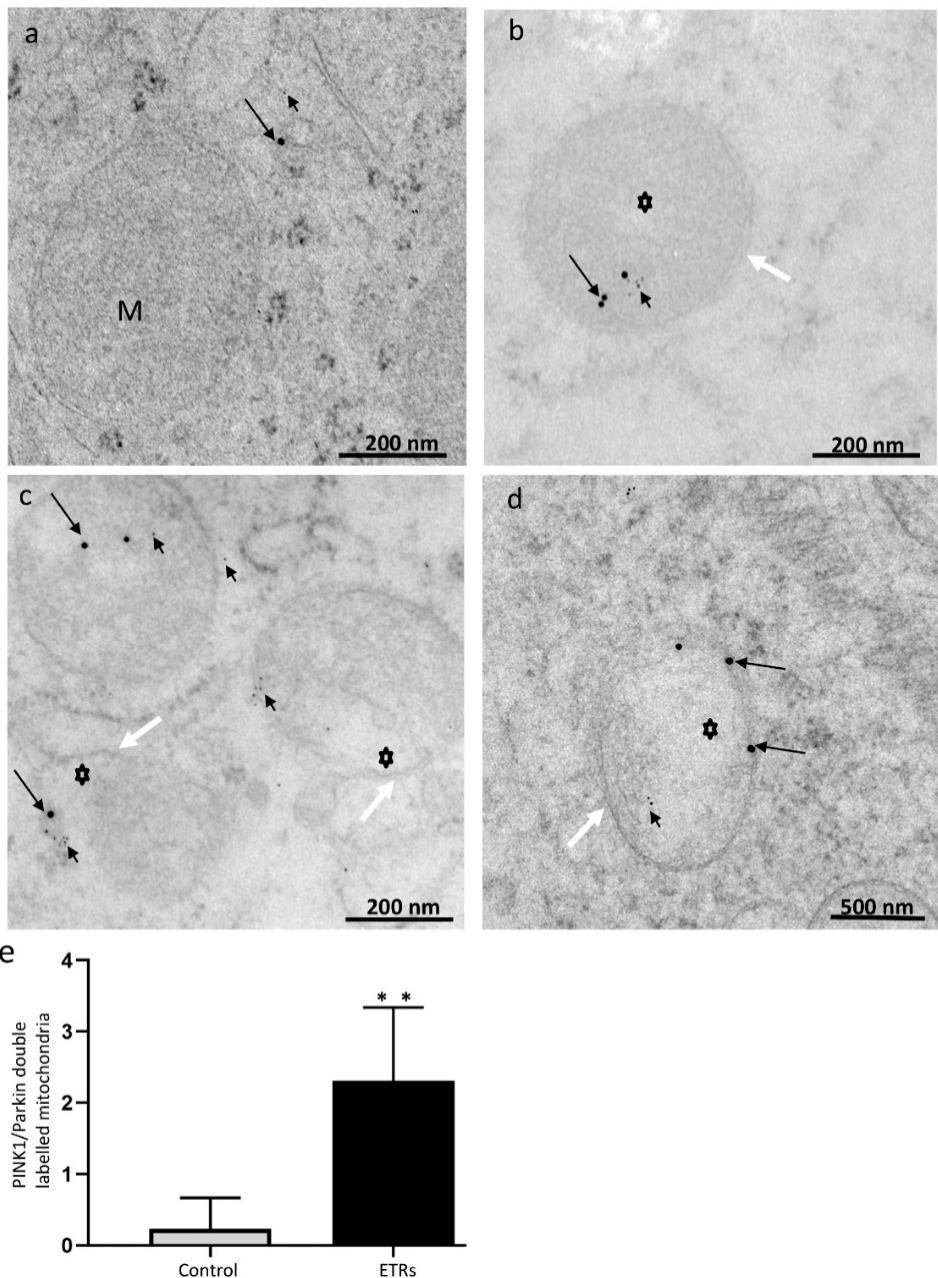
Figure 6. Immunogold double labeling of PINK1 and Parkin in control ( a ) and ETR SCs ( b – d ). The long black arrows indicate PINK1 (labeled with 15 nm gold particles), while short black arrows show Parkin (6 nm gold particles) localizations to damaged mitochondria (asterisks) of ETRs. The white arrows indicate autophagosomal membranes. M, mitochondria; S, SC nucleus. ( e ) Histogram showing quantification of mitochondria positive for both PINK1 and Parkin. ** p < 0.01 ( t -test).